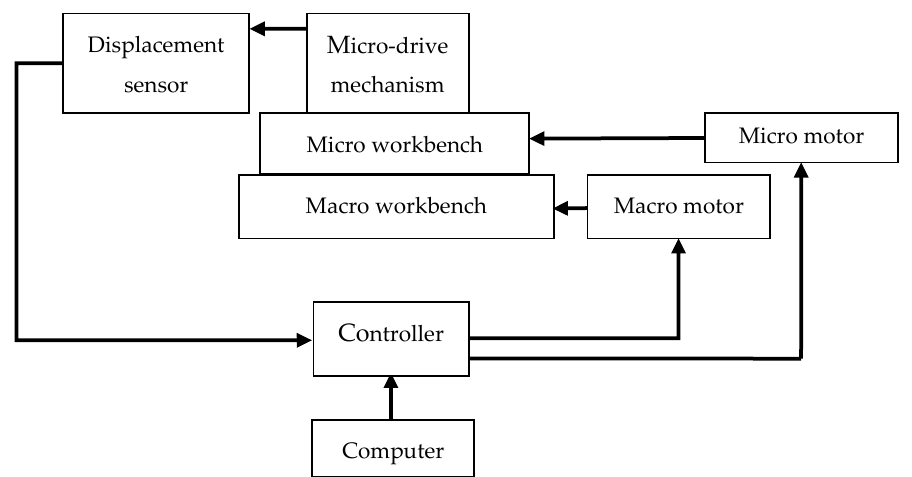
Figure 4. Working principle diagram of macro – micro dual-drive system.